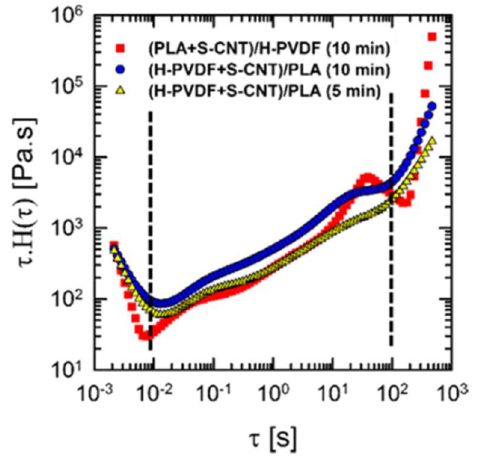
Figure 9. Weighted relaxation spectra of PLA / Polyvinylidene fluoride (PVDF) / CNT systems ((PLA + S-CNT) / H-PVDF: premixed PLA / S-CNT + PVDF; (H-PVDF + S-CNT) / PLA: premixed H-PVDF / S-CNT + PLA)). Reprinted with permission from [123]. Copyright (2019) American Chemical Society.